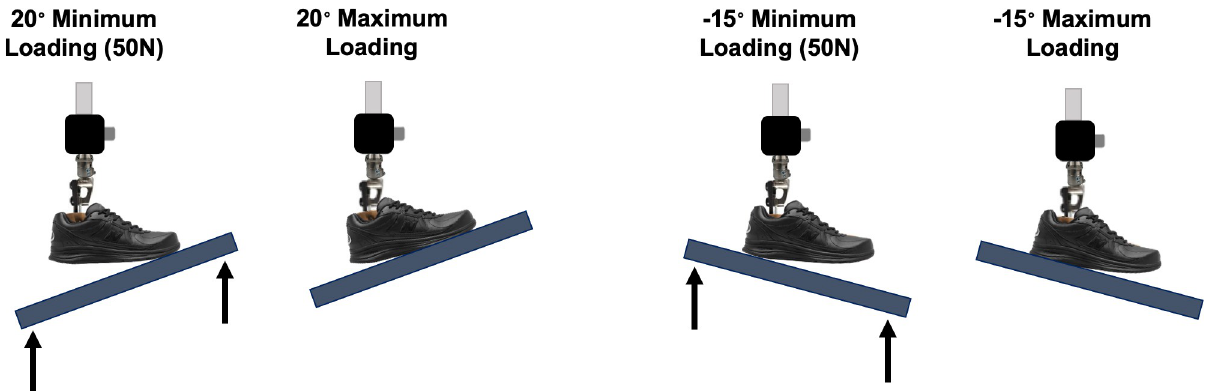
Fig 2. Positioning of loading platform relative to prosthetic foot in mechanical testing apparatus. Diagram of prosthetic foot mechanical testing apparatus demonstrating the positioning of the loading platform relative to the prosthetic foot for +20˚ and -15˚ testing conditions.